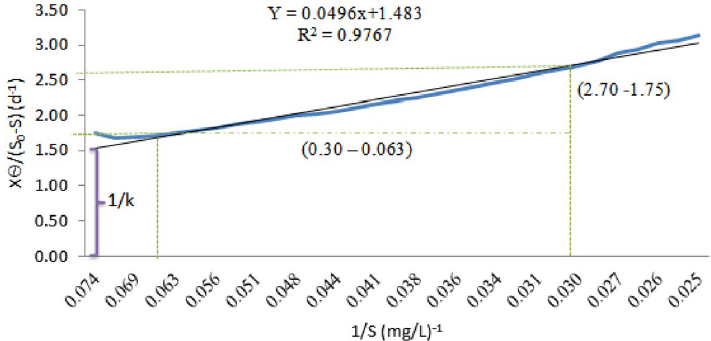
Figure 2. Estimated the k and K s in ASM 1.